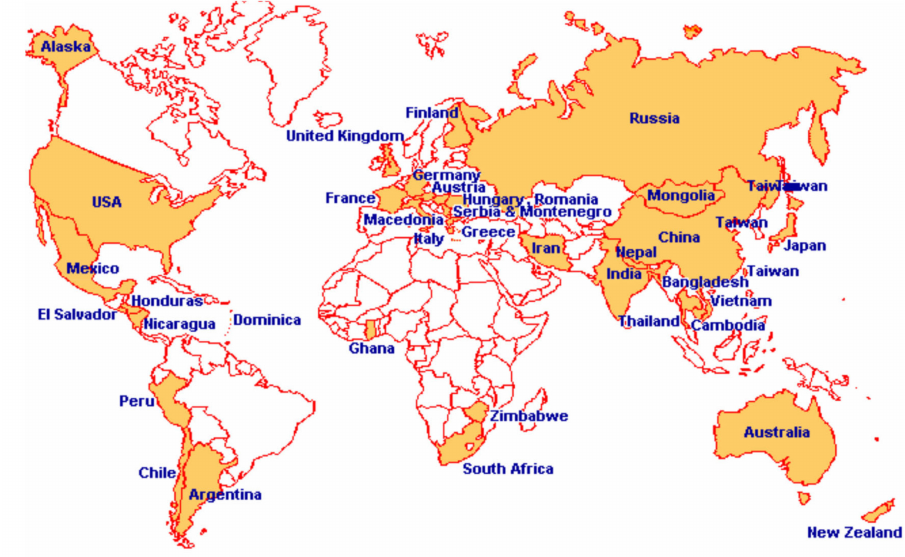
Figure 2. Countries affected by arsenic contamination of groundwater or surface waters [15]. Repro- duced with permission from